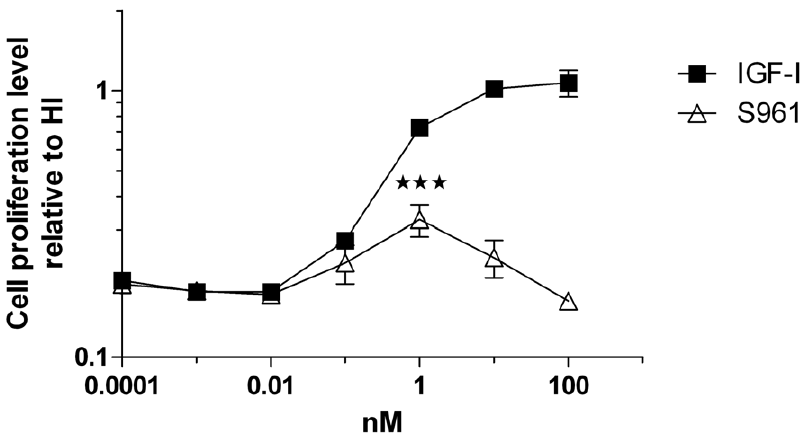
Figure 2. Agonistic (mitogenic) effect of S961 in MCF-7 cells. Cells were stimulated with increasing concentrations of S961 or IGF-I. The graph is representative for three experiments. The increased response for S961 at 1 nM compared to the response at the three lowest concentrations is statistically significant (P , 0.001, two-tailed t-test). Data points represent means of triplicate determinations. Error bars show one standard deviation.